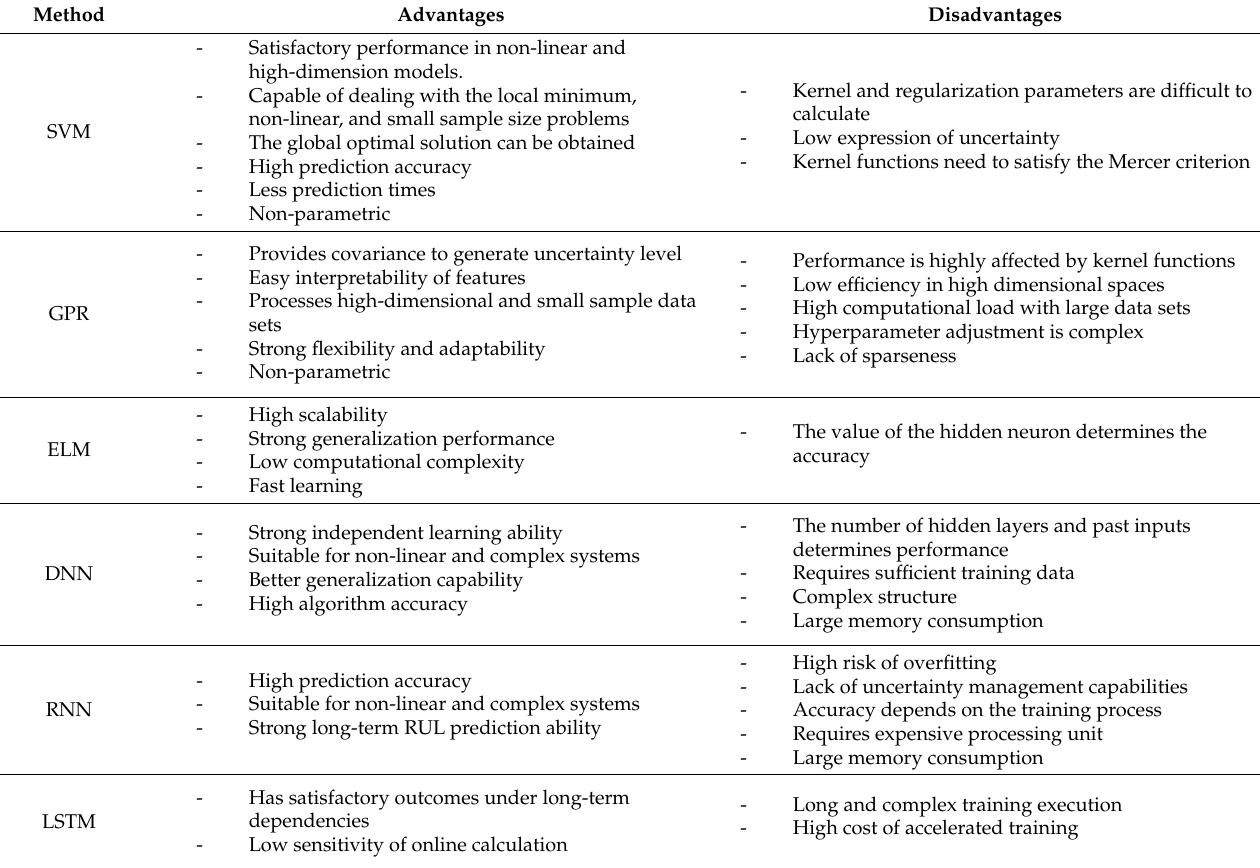
Table 4. Advantages and disadvantages of the different ML techniques used for RUL prediction. Method Advantages